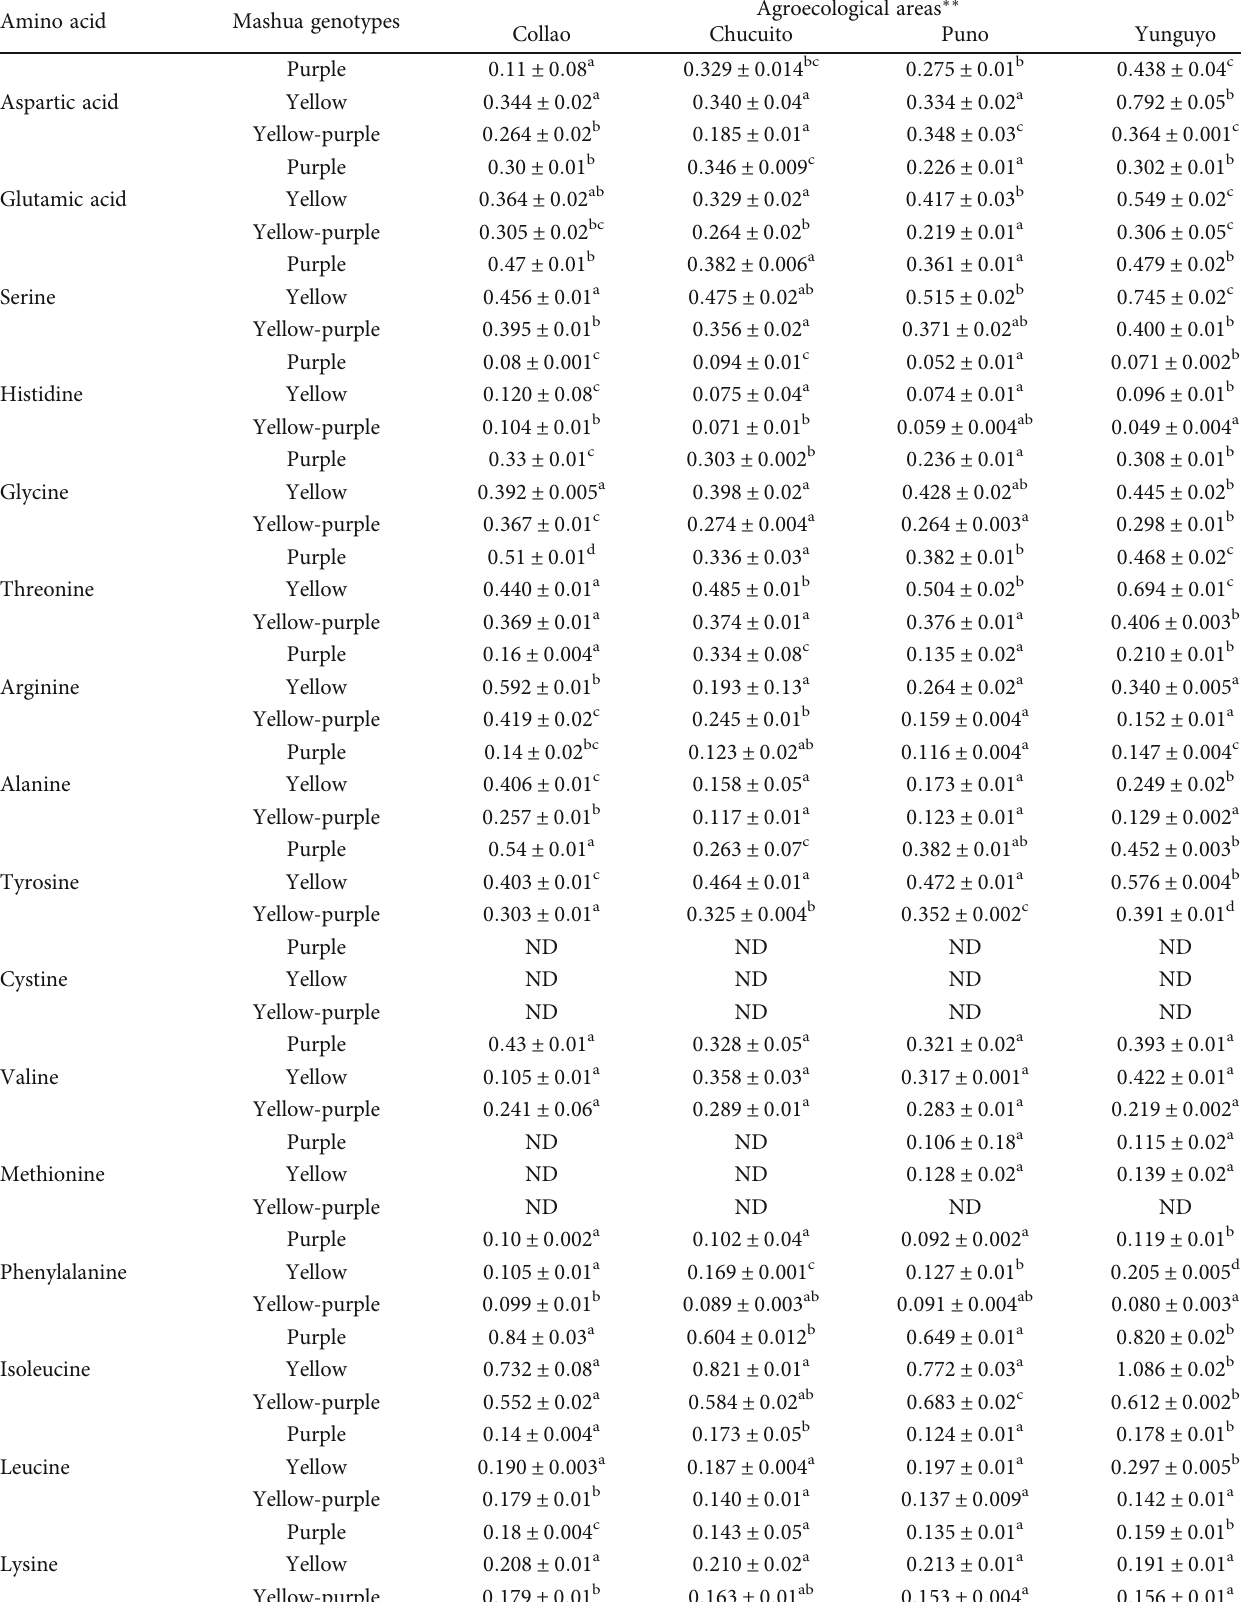
Table 2: E ff ect of agroecological areas on the content of amino acids (mg/g DM) from the three mashua genotypes ∗